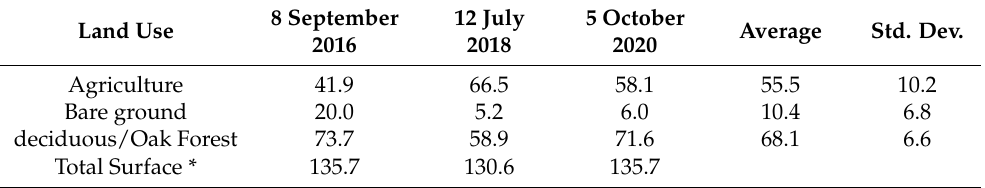
Table 2. Summary of the area (km 2 ) detected from remote sensing into the Ixcatepec catchment. Land Use